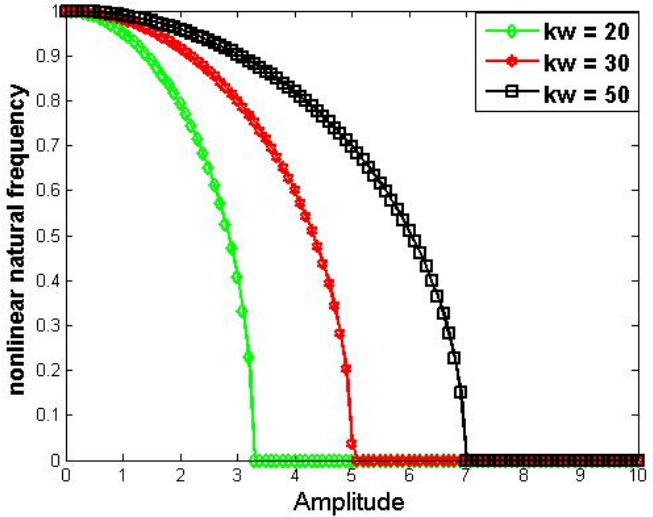
Figure 3. Influence of elastic foundations on nonlinear natural